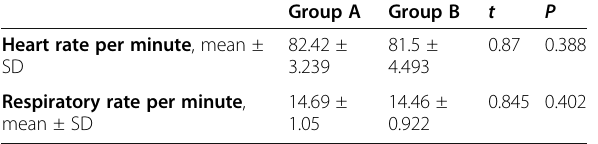
Table 9 Comparison between the two groups regarding postoperative heart rate per minute and respiratory rate per minute every 2 h for 48 h after end of